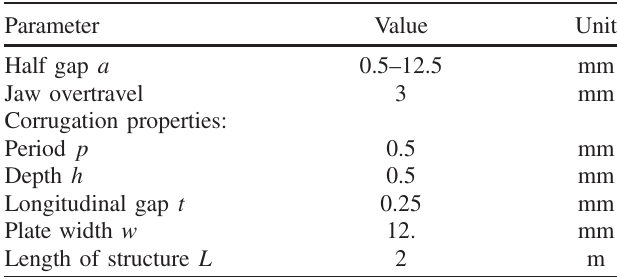
TABLE I. Parameters of the RadiaBeam/SLAC